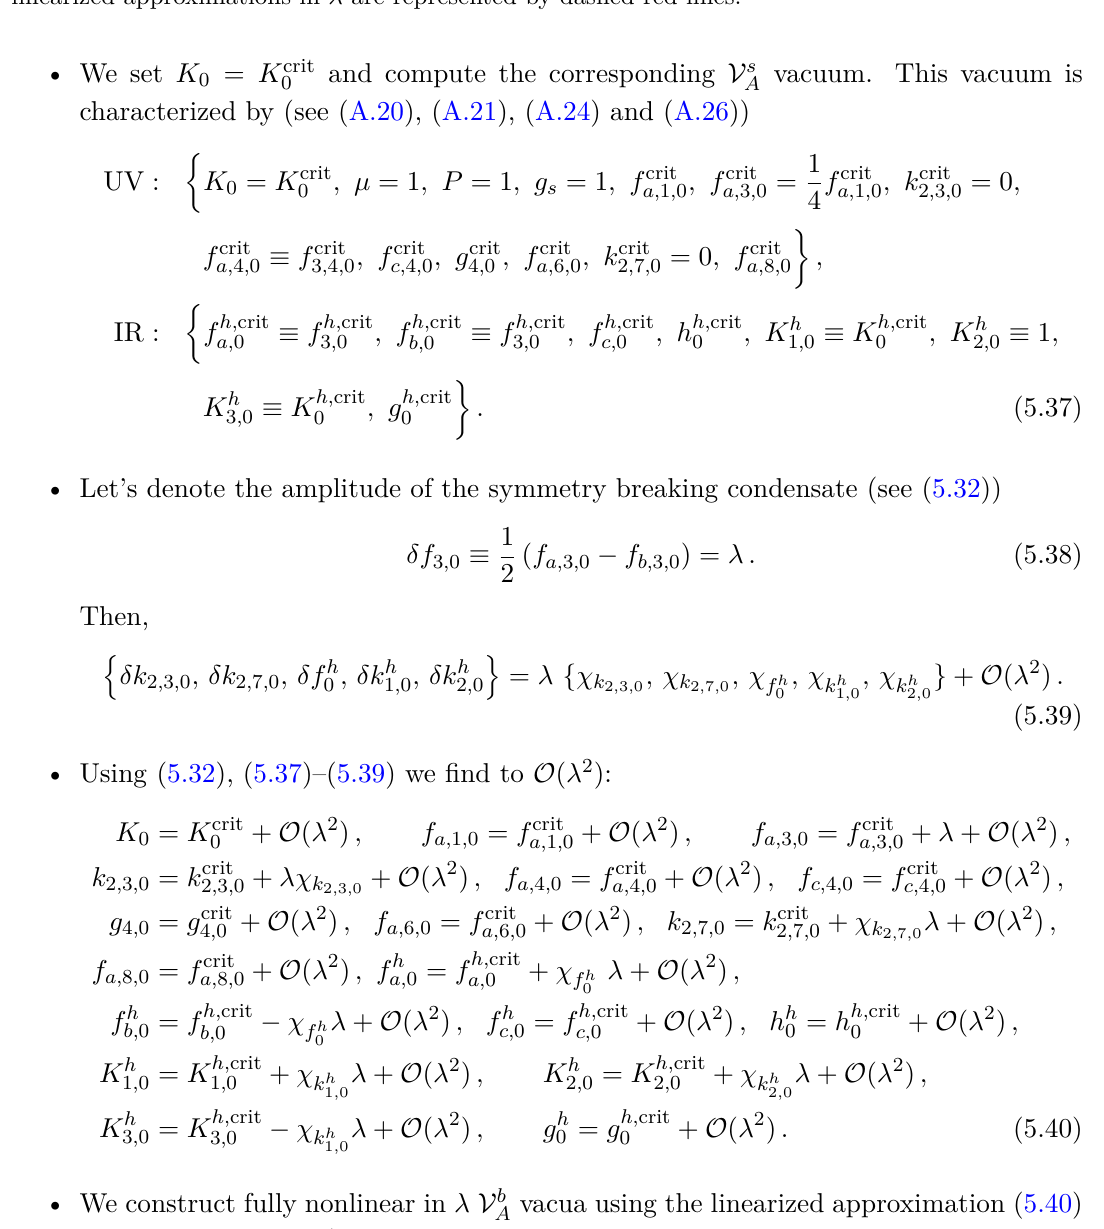
b vacua constructed from the ‘seed’ (5.40). The A V